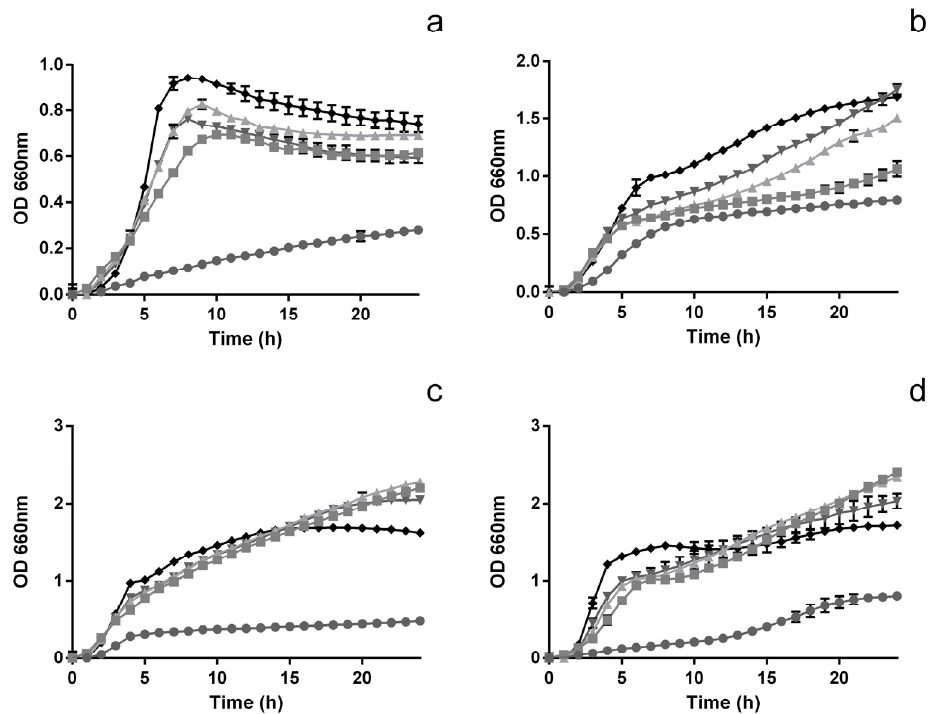
Figure 1. Time inhibition curves for L. monocytogenes ( a ), E. coli ( b ), S. enteritidis ( c ) and B. cereus ( d ) when exposed to different concentrations of extract; 1000 µ g mL ( ), 500 µ g mL ( ■ ), 250 µ g mL ( ▲ ), 125 µ g mL ( ▼ ) and 0 µ g mL ( ♦ ).